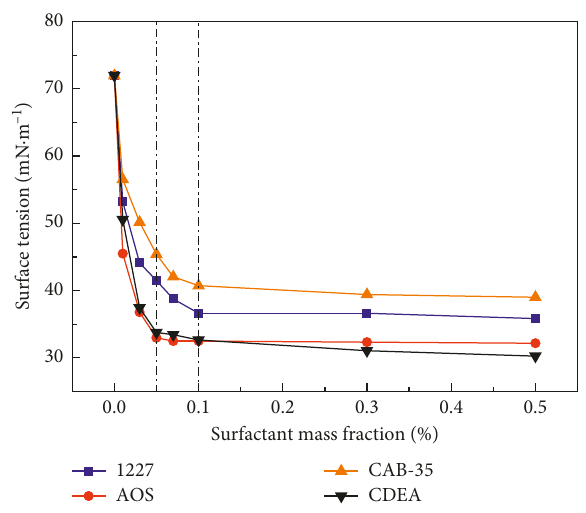
Figure 2: Surface tension of the surfactants at the different